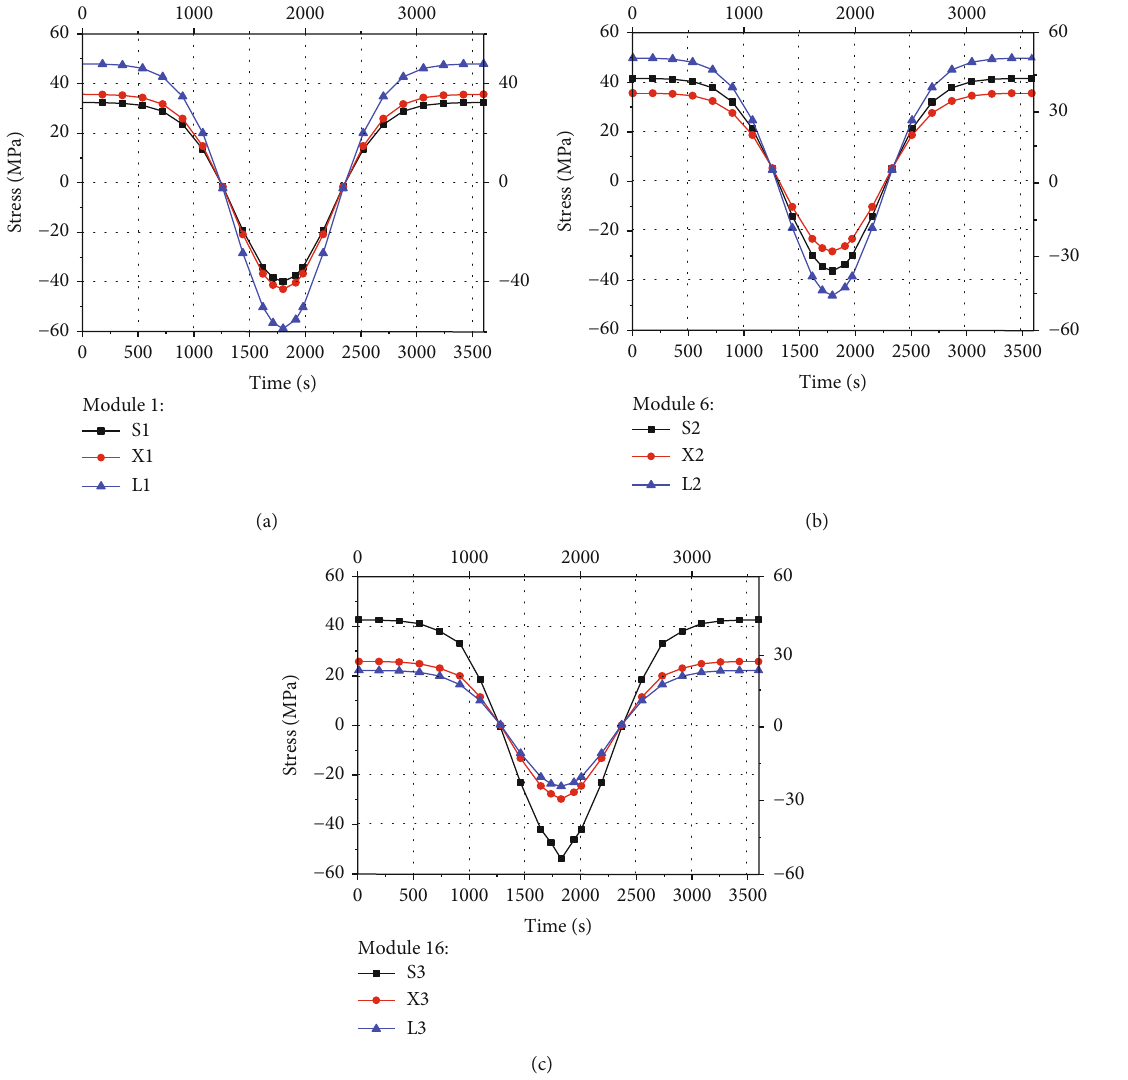
Figure 7: The thermal stress distribution of di ff erent rods in the same module. (a) Module 1. (b) Module 6. (c) Module